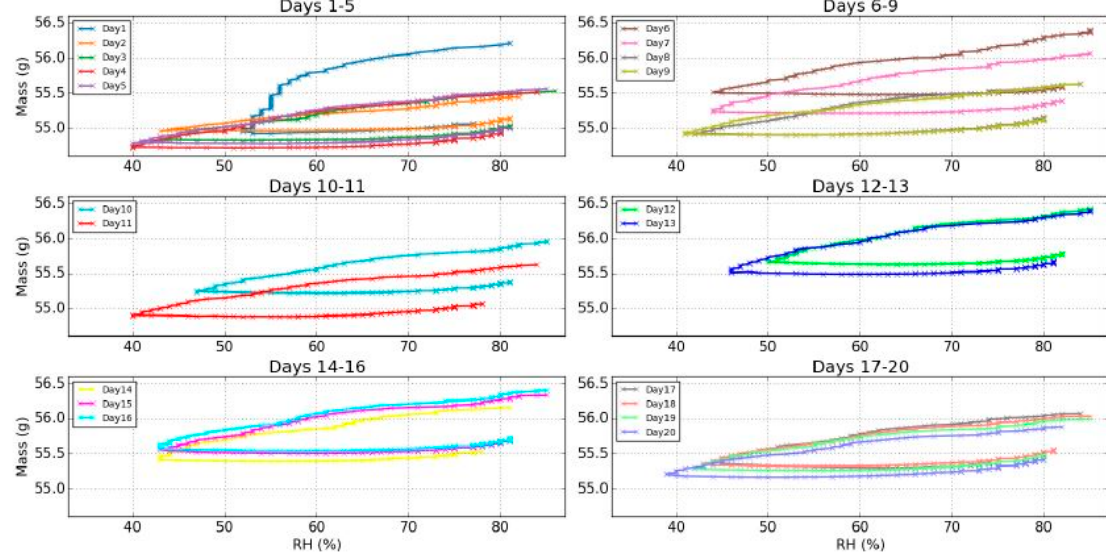
Figure 14. Evolution of the isotherms during the twenty days of experiments. Figure 14 . Evolution of the isotherms during the twenty days of experiments . Figure 14 . Evolution of the isotherms during the twenty days of experiments .